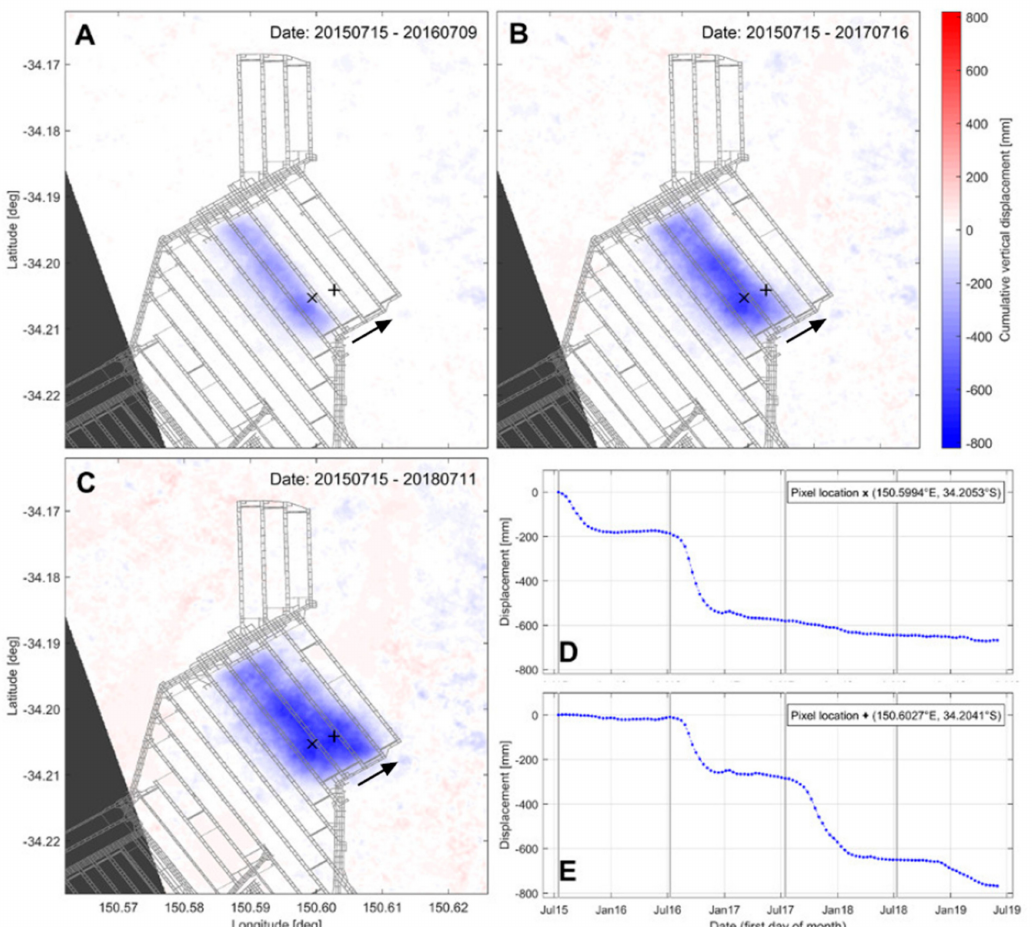
Figure 6. Cumulative vertical displacements at the Tahmoor longwall coal mine, New South Wales, derived from the InSAR analysis of RADARSAT-2 data between 20150715 and 20190531. ( A – C ) display the cumulative vertical displacement at 1-year intervals (i.e., July 2016, July 2017, and July 2018, respectively) relative to the first epoch (July 2015). The magnitude and spatial extent of displacements increases over time. The location of longwall panels is overlaid in grey. The arrow shows the progression of longwall extractions, with the most southwestern longwall extracted first. ( D , E ) show vertical displacement time-series for two locations marked by ‘x’ and ‘+’ in ( A – C ). The epochs displayed in ( A – C ) are marked by vertical grey